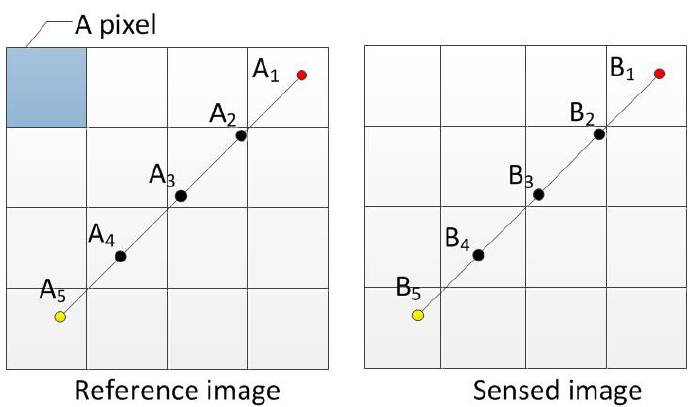
A B and B 1 5 1 5